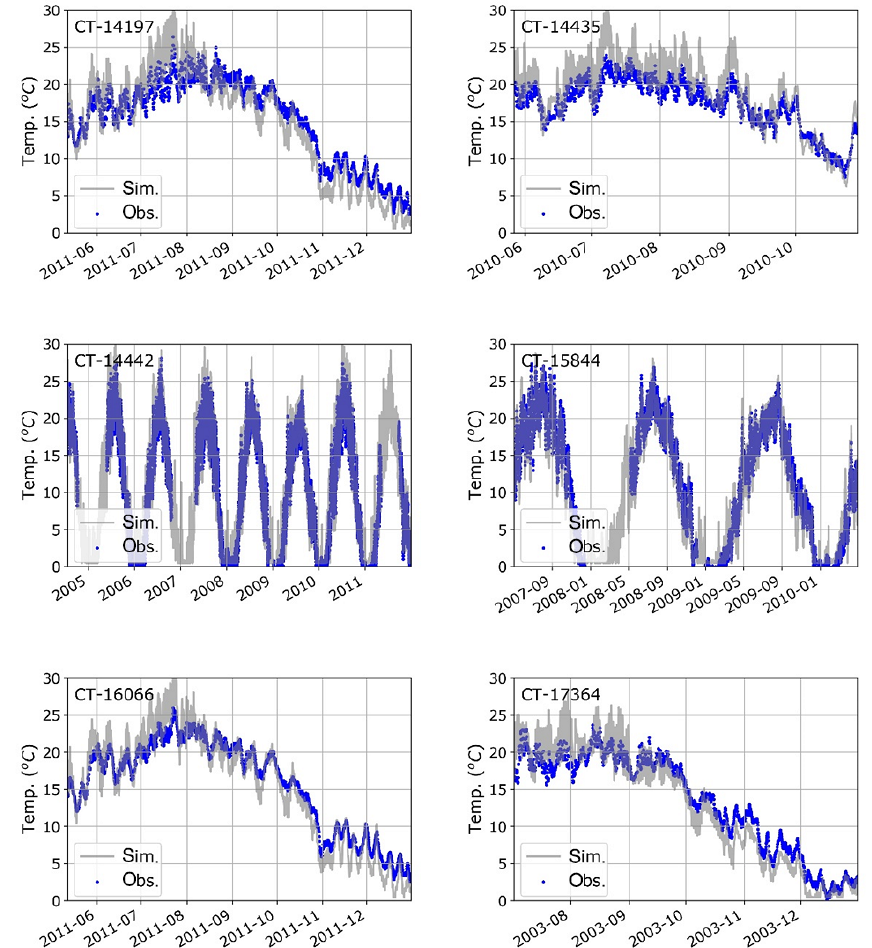
Figure 5. Time series comparing simulated and observed 3-hourly stream temperatures at six selected CTDEEP sites in the Farmington River basin. The period of available temperature observations varies by location. Table 7. Percentage of watershed with Cold, Cool or Warm thermal class for watershed management scenarios described in Sect. 3.4. Metrics for estimating thermal classes are from Table 6 (following Beauchene et al.,